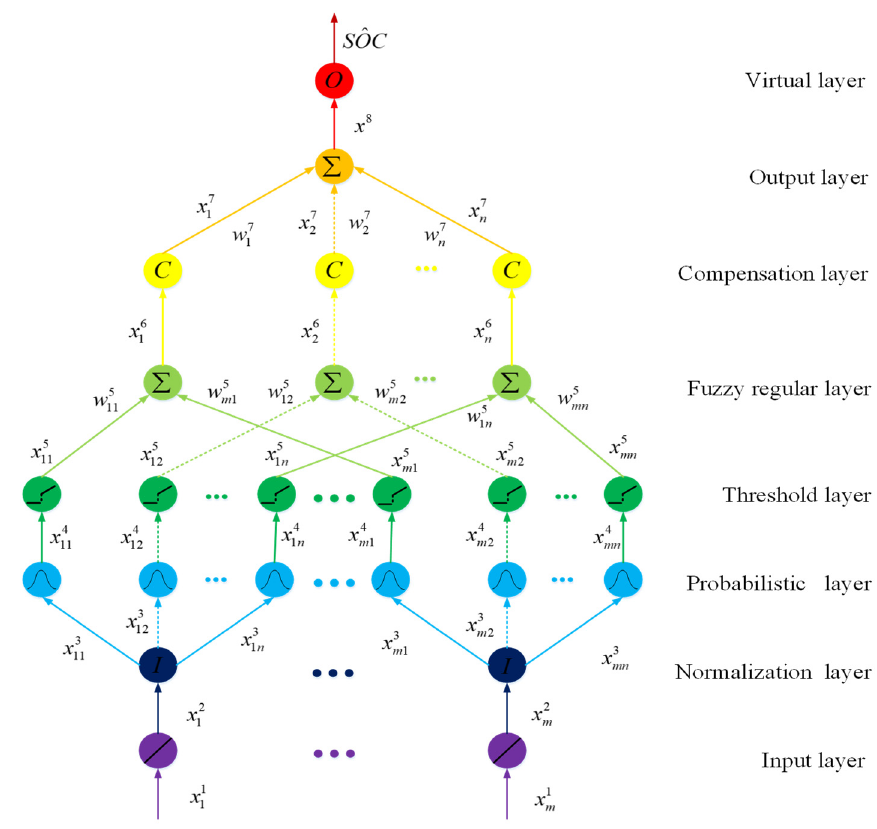
Figure 3. Structure of the PTCFNN.